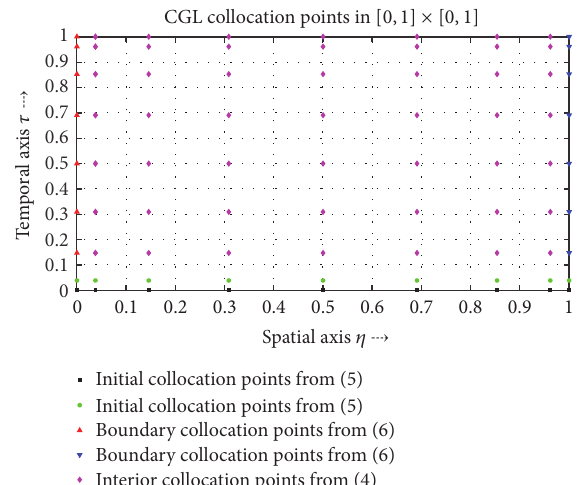
Algorithm 1 can describe BCM for solving 1D diffusion